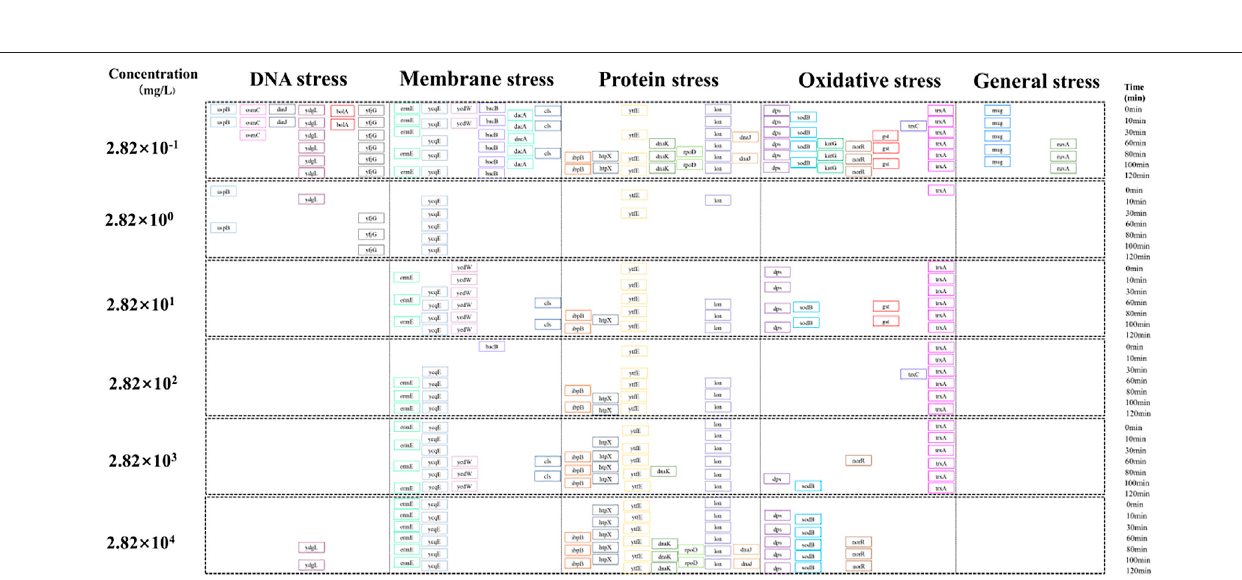
FIGURE 7 | Altered expression of genes involved in the different stress